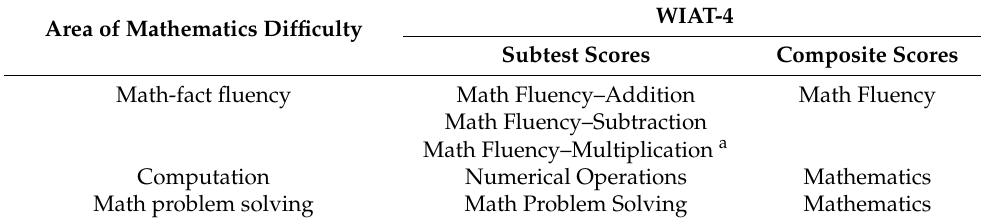
Table 6. WIAT-4 Mathematics